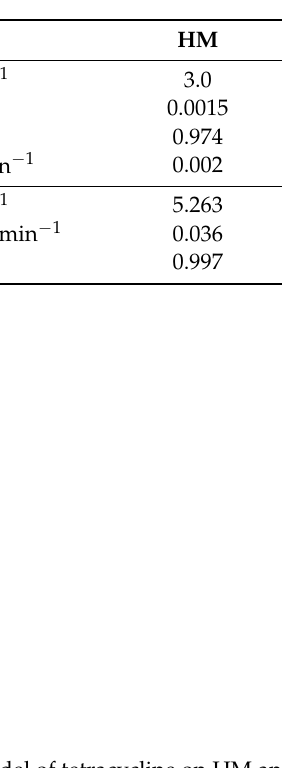
Table 1. Calculation of adsorption kinetics.